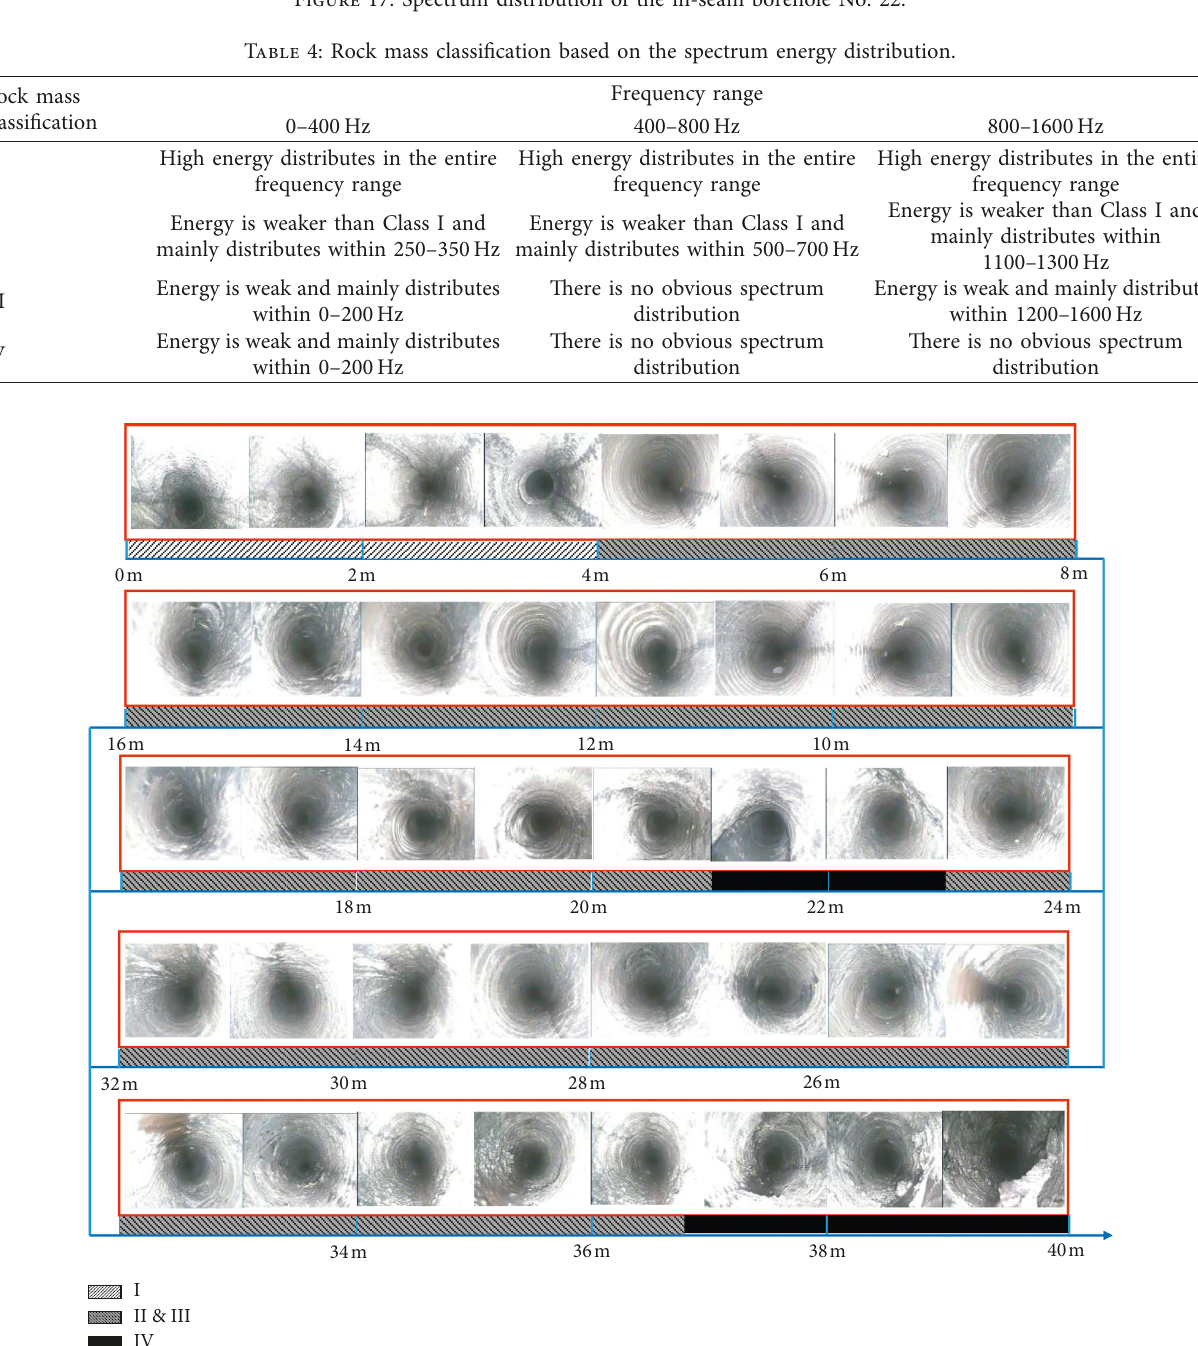
Figure 18: Photos of borehole No. 12 at different